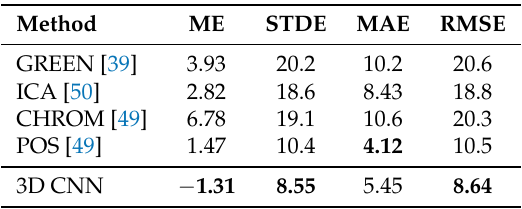
Table 3. Performance of pulse rate measurement for selected UBFC-RPPG image sequences. ME: mean of pulse rate error; STDE: standard deviation of pulse rate error; MAE: mean absolute error (Equation (9)); RMSE: root mean square error (Equation (10)); GREEN: pixel averaging in the green channel; ICA: independent component analysis; CHROM: chrominance method; CNN: convolutional neural